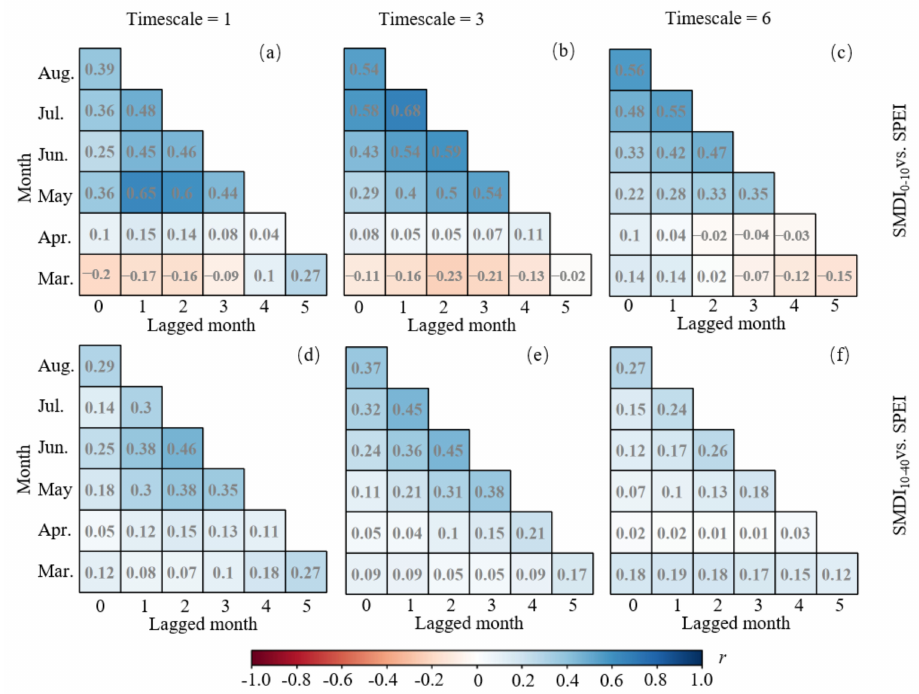
Figure 5. The r values between SPEI and SMDI 0–10 ( a – c ) or SPEI and SMDI 10–40 ( d – f ) at the 1, 3 and 6-month timescales with lagged time of 0 to 5 months during growth period of spring wheat (March to